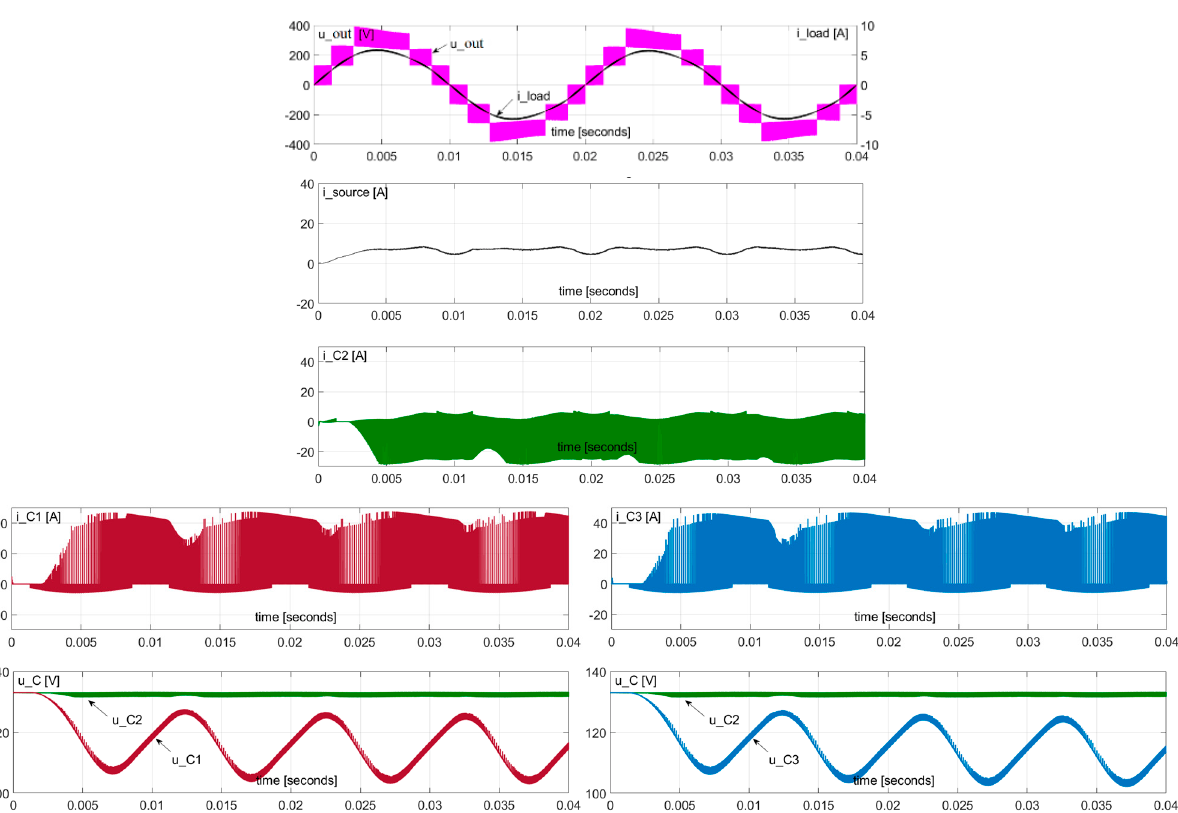
Figure 13. Waveforms of the seven-level inverter with three input voltage sources: output voltage, load voltage and current, voltages and currents of DC-link capacitors and the source. 5 ms/div, P out = 1 kW, L f = 6 μ H.